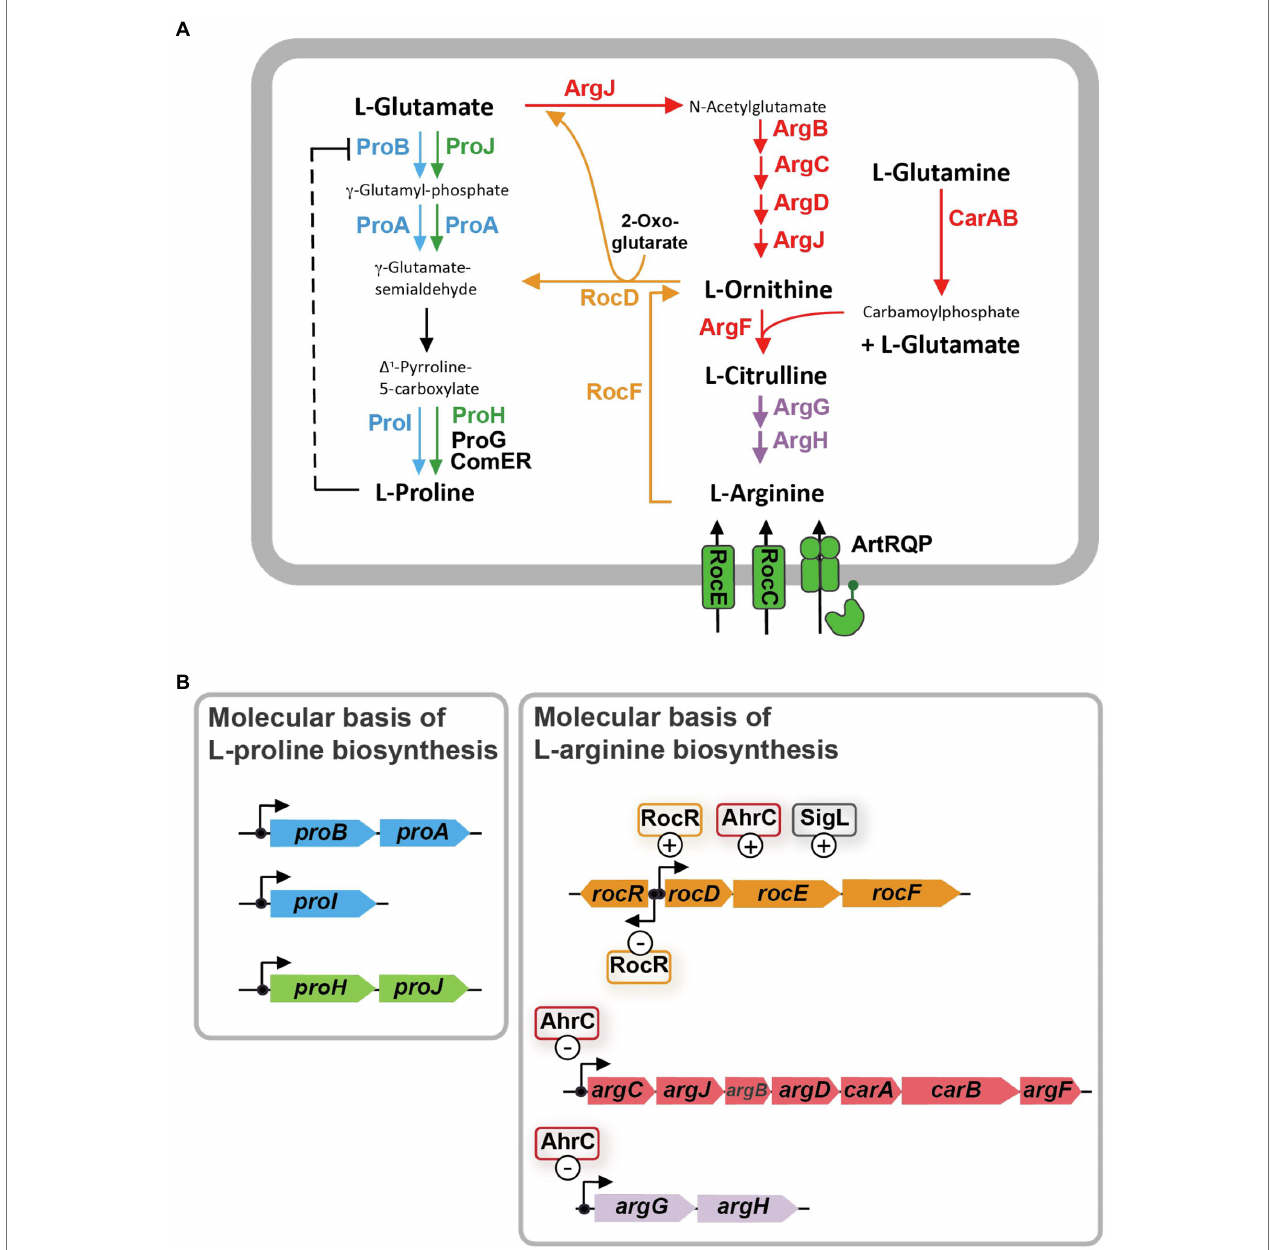
FIGURE 1 | L-arginine biosynthesis and degradation pathways are metabolically interconnected with the L-proline biosynthetic route in Bacillus subtilis . (A) Schematic overview of the precursors, intermediates, and products of L-arginine synthesis and catabolism, and the anabolic and osmostress-responsive L-proline biosynthetic route. The ProB-ProA-ProI enzymes (blue) are used for anabolic L-proline production, while the ProJ-ProA-ProH (green) route is employed for the synthesis of L-proline as an osmostress protectant. γ -glutamate-semialdehyde spontaneously converts to Δ 1 -pyrroline-5-carboxylate which is the substrate for the Δ 1 -pyrroline-5-carboxylate reductase; four of these types of enzymes operate in B. subtilis . The precise physiological functions of the ProG and ComER enzymes are not entirely clear. (B) Molecular and regulatory overview of L-proline and L-arginine biosynthetic genes and those for L-arginine degradation. Positive and negative influence of known regulatory proteins on gene expression are highlighted. These data for this figure were compiled from the